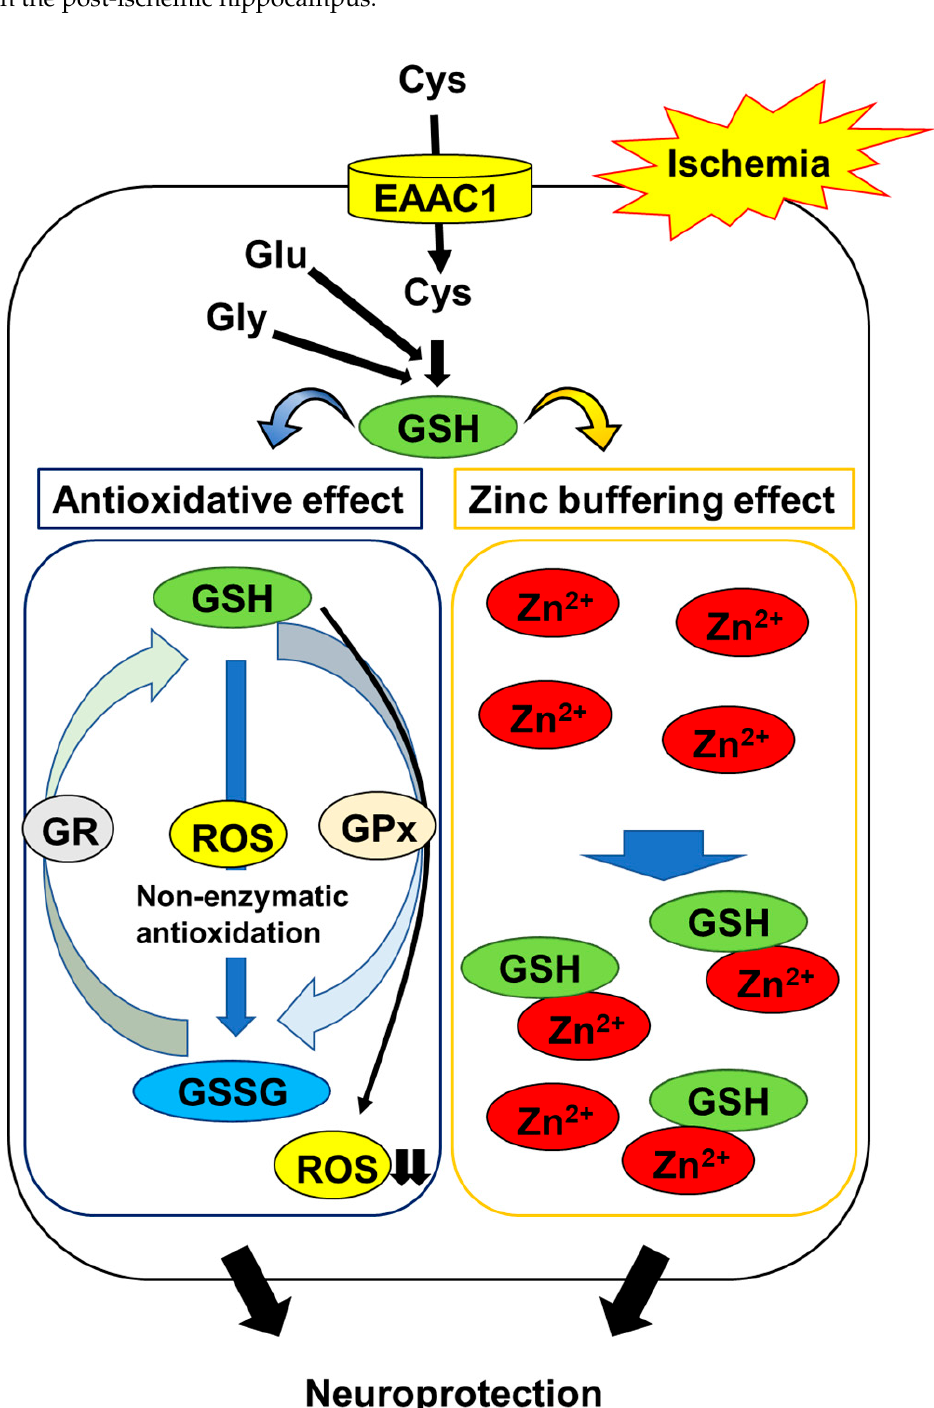
Figure 1. Mechanisms of GSH protection against hippocampal neuron damage following brain ischemia. The abbreviations are as follows: cysteine (Cys), glutamate (Glu), glycine (Gly), excitatory amino acid carrier 1 (EAAC1), glutathione (GSH), glutathione disulfide (GSSG), GSH reductase (GR), GSH peroxidase (GPx), reactive oxygen species (ROS).